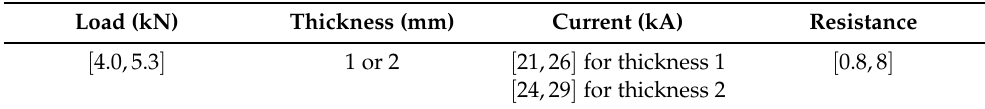
Table 3. Control inputs and calibration